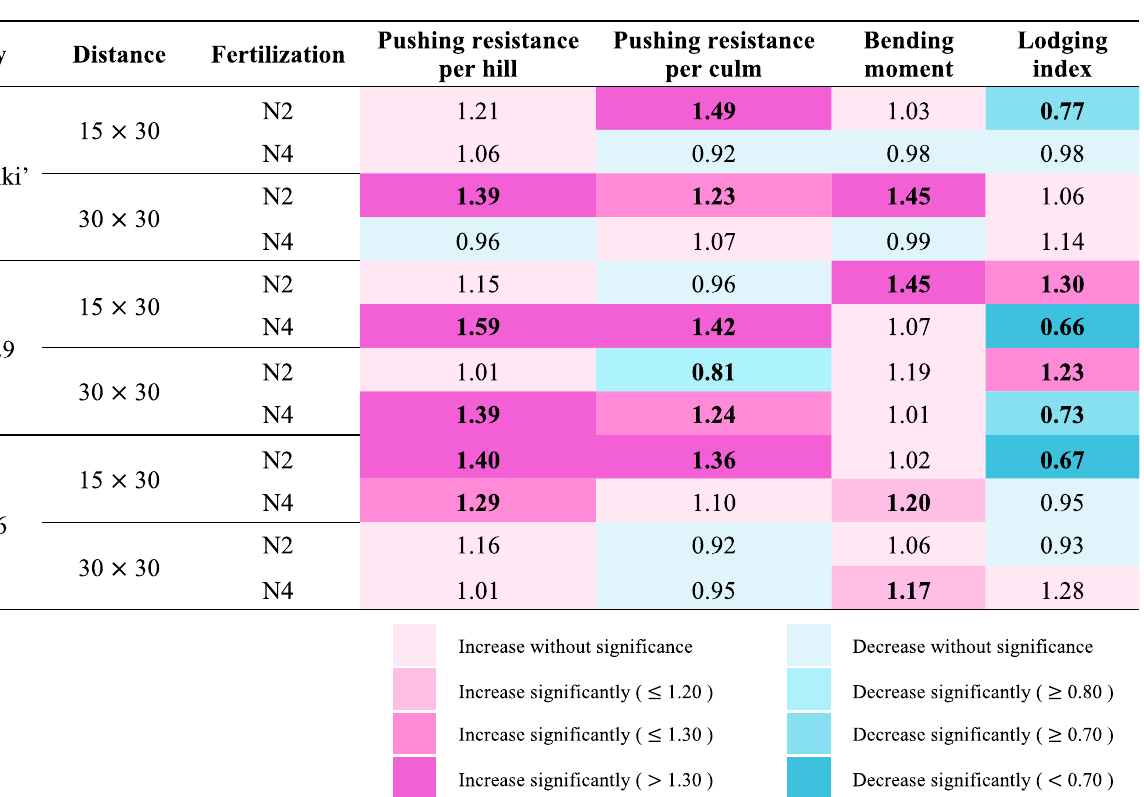
Figure 5. Heatmap for lodging factors showing the ratio of biofertilizer inoculated to non-inoculated. Values indicate the ratio of biofertilized/non-inoculated plants. ‘ Fukuhibiki ’ , LTAT-29, and TAT-26 measured at 119, 137, and 147 days after transplanting, respectively. Lodging degrees measurement were as follows, ‘ Fukuhibiki ’ = 0.0, LTAT-29 = 1.0, TAT-26 = 3.0. Bold indicate significant differences at p ≤ 0.05 and 0.01 levels between control and biofertilizer application in each treatment, respectively ( t -test, two-sided). n = 10.